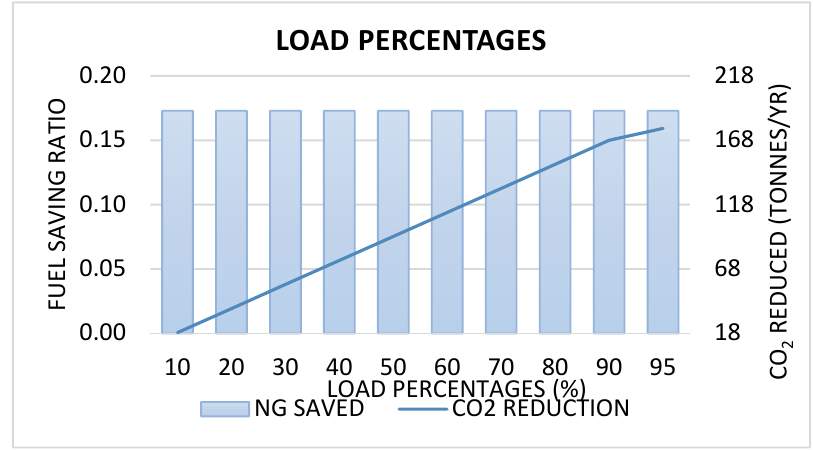
ff erent Load 2 Reduction under Di